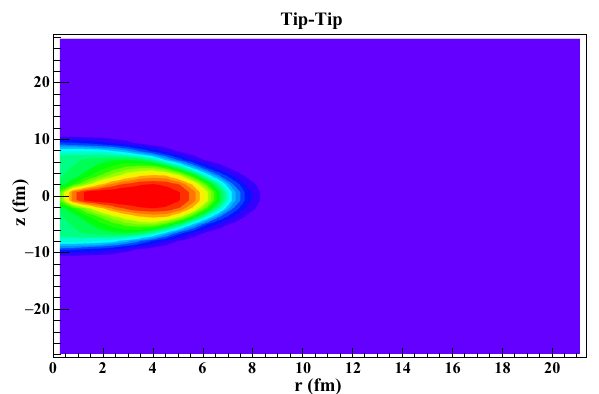
Fig. 2 Nuclear density contour in r − z plane of cylindrical coordi- nate system for uranium nucleus in tip configuration. Representation of colours is same as in the case of Fig. 1